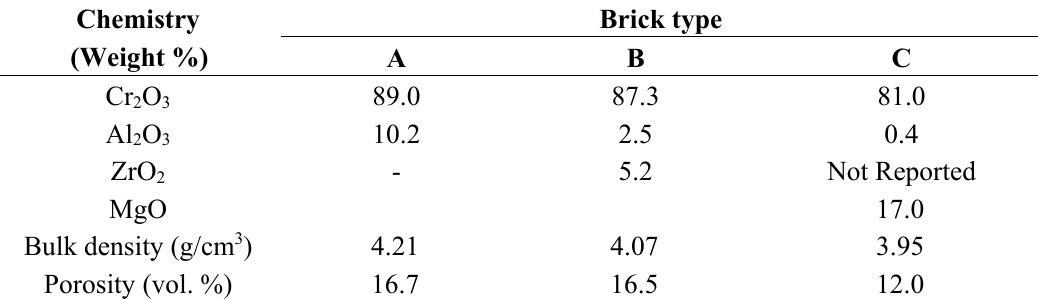
Table 5. Chemical composition and physical properties of commonly used high Chrome